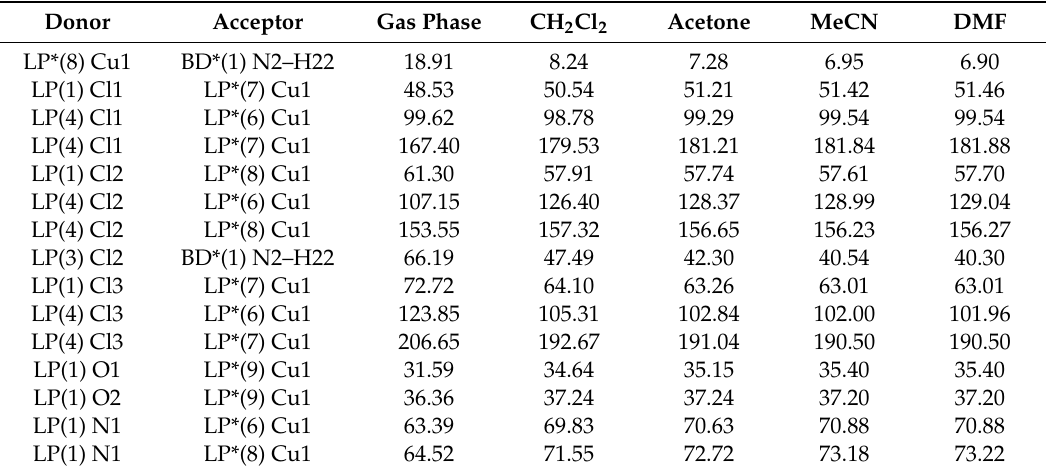
Table 2. DFT-calculated second-order perturbation energies E (2) (kJ / mol) of selected orbital interactions in (HNEt 3 )[Cu(pydicMe 2 )Cl 3 ] in the gas phase and solvents a . Donor